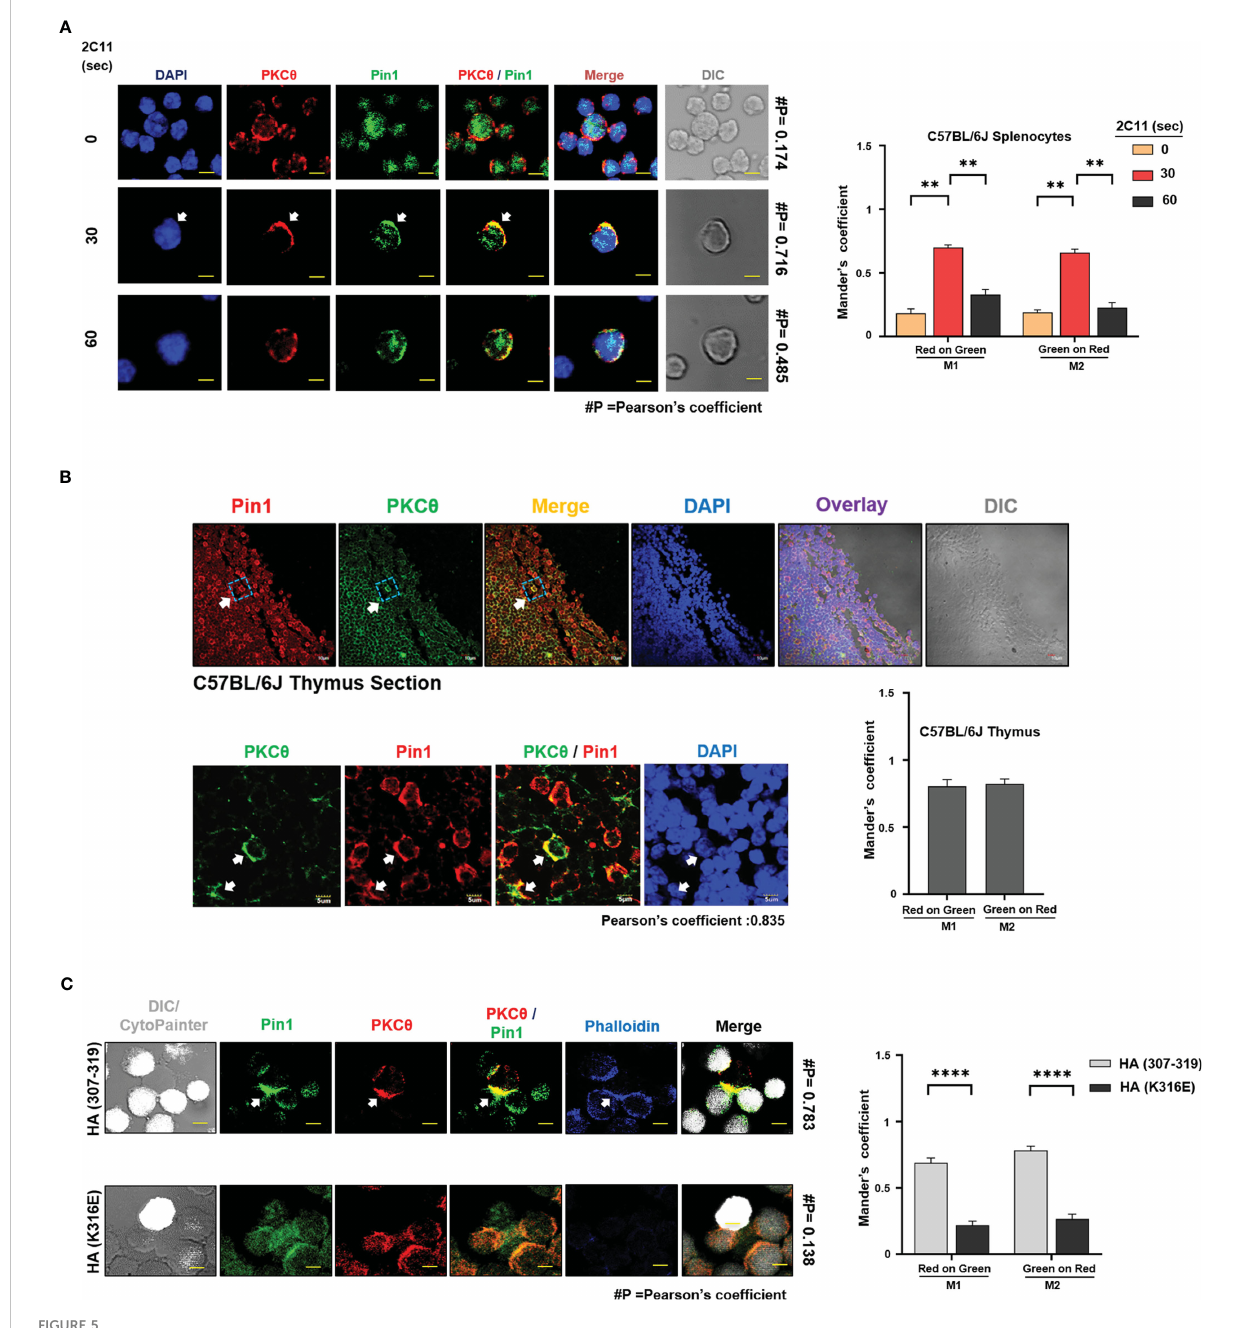
FIGURE 5 TCR engagement promotes PKC q and Pin1 clustering at the plasma membrane within the immunological synapse. (A) Confocal laser microscopy analysis of Pin1 and PKC q distribution in 2C11-stimulated C57BL/6J-derived splenic T cells. Arrow indicates Pin1-PKC q colocalization. Scale bar, 5 m m. Quanti fi cation of red (PKC q ) and green (Pin1) colocalization was assessed using the JACoP plugin from ImageJ. #P indicates the Pearson ’ s colocalization coef fi cient. Mander ’ s coef fi cients indicate the fraction of red overlapping with green (M1) and green overlapping with red (M2), respectively. Mean ± SEM (n=9), **P<0.001 (one-way ANOVA, Tukey ’ s Multiple Comparison Test) (B) Confocal laser microscopy analysis of Pin1 and PKC q distribution in C57BL/6J mouse thymic sections. Arrows indicate Pin1-PKC q colocalization. Scale bar, 10 m m (inset); 5 m m (zoom). Quanti fi cation of red (Pin1) and green (PKC q ) colocalization was assessed using the JACoP plugin from ImageJ. Pearson ’ s colocalization coef fi cient is indicated below the Image. Mander ’ s coef fi cients indicate the fraction of red overlapping with green (M1) and green overlapping with red (M2), respectively, and is represented in a bar graph. Mean ± SEM (n=9). (C) Conjugate formation between Jurkat T cells, clone CH7C17, and APCs (derived from the LG2 B cell line). Following antigen ( HA peptide 307-319, or an inactive HA peptide, HA-K316E ) pre-pulsing and coincubation for 5 min, T cells and APCs were fi xed, permeabilized, stained and analyzed by confocal microscopy (scale bar equals 2 m m). Immuno fl uorescence staining was performed using primary Abs; mouse anti-PKC q , and rabbit anti-Pin1, followed by Alexa Fluor 633-conjugated phalloidin and secondary Abs, Alexa Fluor 488- conjugated anti-mouse IgG Abs and Alexa Fluor 546-conjugated anti-rabbit IgG Abs. CytoPainter stain was detected at 405nm wavelength. Quanti fi cation of red (PKC q ) and green (Pin1) colocalization was assessed using the JACoP plugin from ImageJ. Mander ’ s coef fi cients indicate the fraction of red overlapping with green (M1) and green overlapping with red (M2), respectively. Mean ± SEM (n=9), **** P<0.0001 (ordinary two-way ANOVA). DIC, Differential interference contrast. Results are representative of three independent